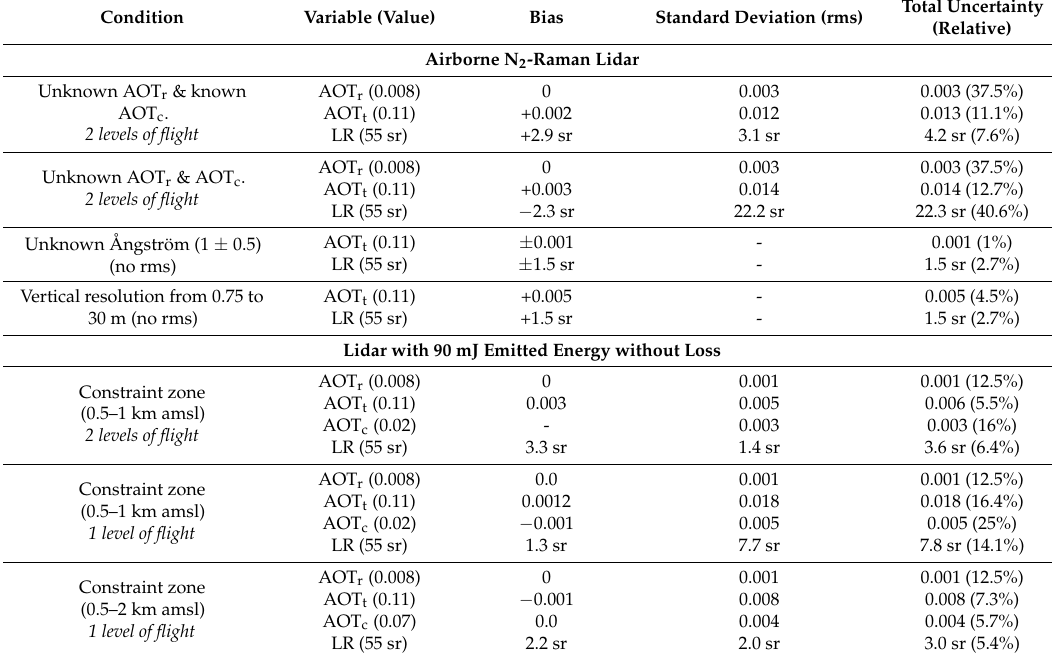
Table 4. Results of the Monte Carlo approach in terms of bias, standard deviation (rms) and total uncertainty for the AOT (i) at the reference (AOT r ); (ii) for the total vertical profile (AOT t ); (iii) at the constraint zone (AOT c ), as well as for the Lidar ratio (LR). When useful, we also indicate in italic type whether the inversion is carried out with one or two levels of